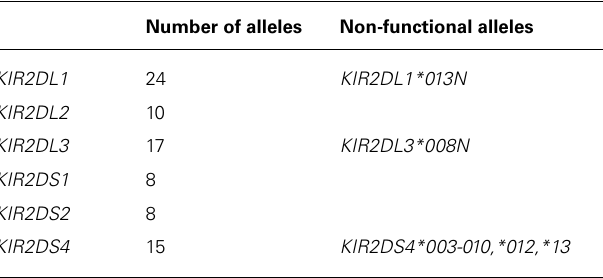
Table 4 | Polymorphism of HLA-C reactive KIR.